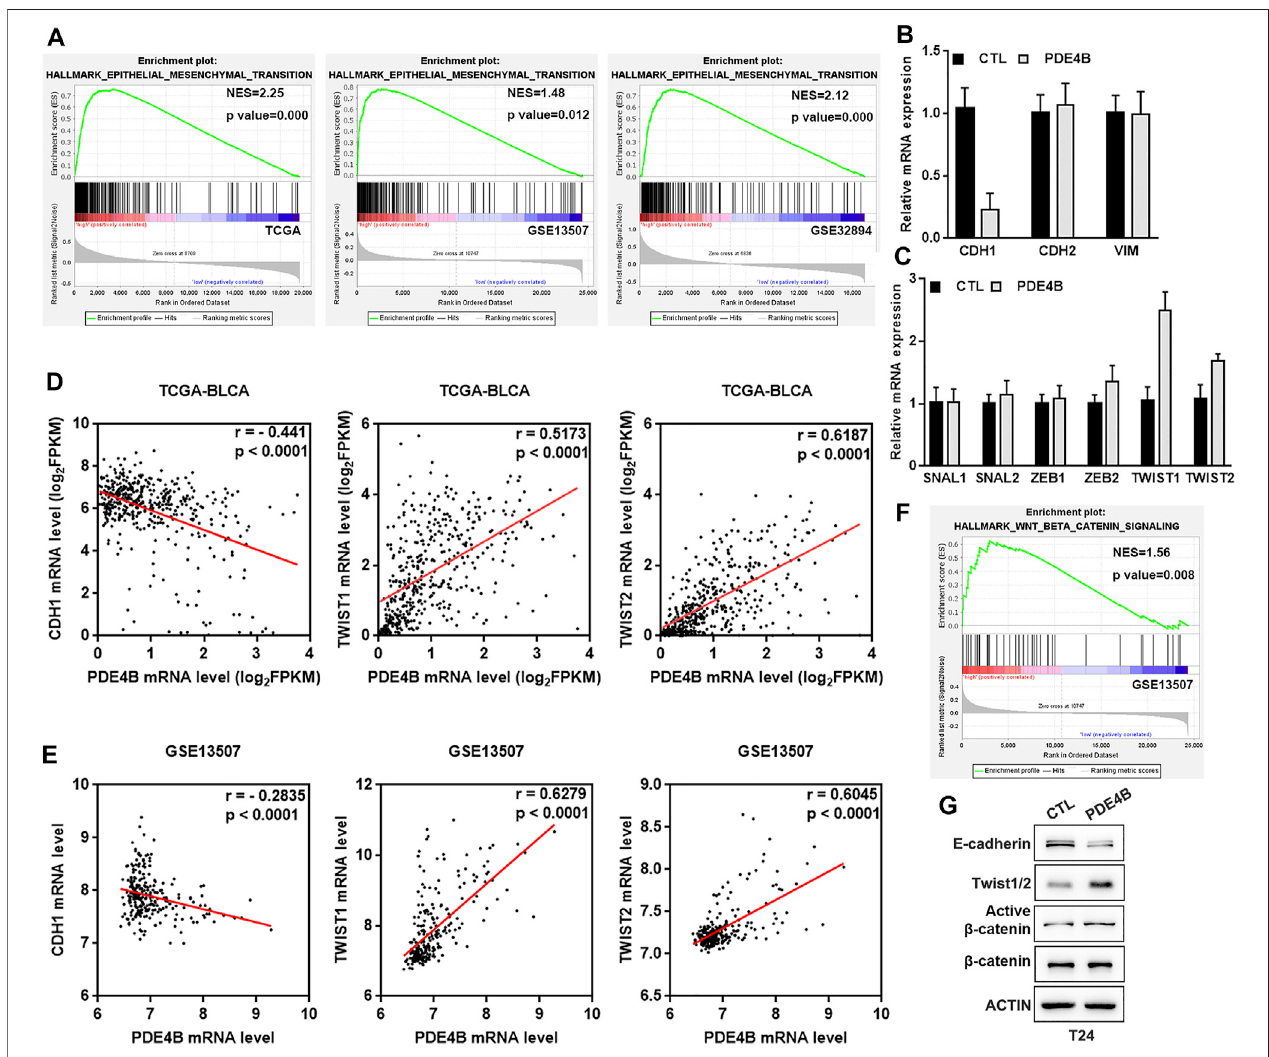
FIGURE 7 | PDE4B induces UBC cells EMT via β -catenin pathway. (A) GSEA enrichment on the association of PDE4B expression with EMT gene sets based on TCGA-BLCA, GSE13507, and GSE32894 databases. (B,C) The mRNA expression of EMT-associated markers and transcription factors upon PDE4B overexpression weremeasuredbyqRT-PCR. (D,E) ThecorrelationbetweenPDE4BandE-cadherin,TWIST1,TWIST2expressionwasanalyzedbyPearsoncorrelationanalysisinUBC patients from TCGA-BLCA and GSE13507 databases. (F) GSEA enrichment on the association of PDE4B expression with Wnt/ β -catenin pathway based on GSE13507 database. (G) The expression of EMT relative factors and activation of the β -catenin pathway were detected by western blotting in T24 cells with PDE4B overexpression.